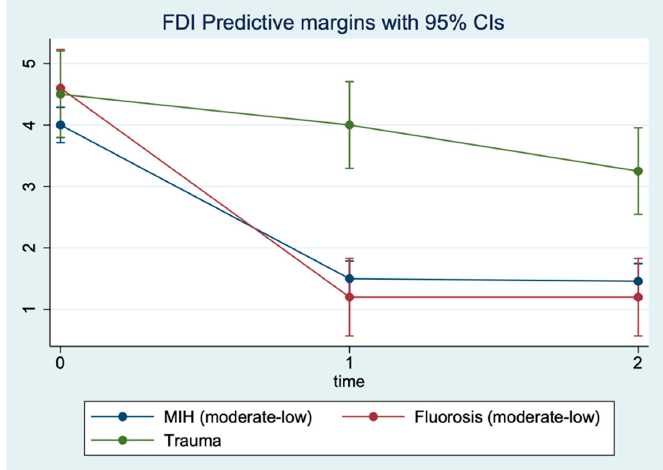
Figure 5. FDI levels predicted by repeated measures (three timepoints) restricted maximum likelihood mixed model. Table 3. Mixed model regression on FDI.